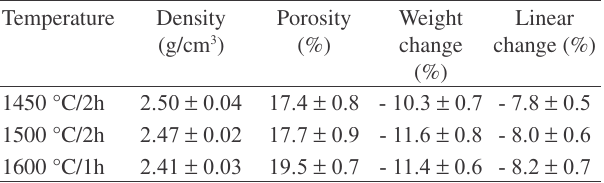
Table 1. Density, open porosity, weight and linear dimensional change of samp les pyrolysed at the three different temperatures.